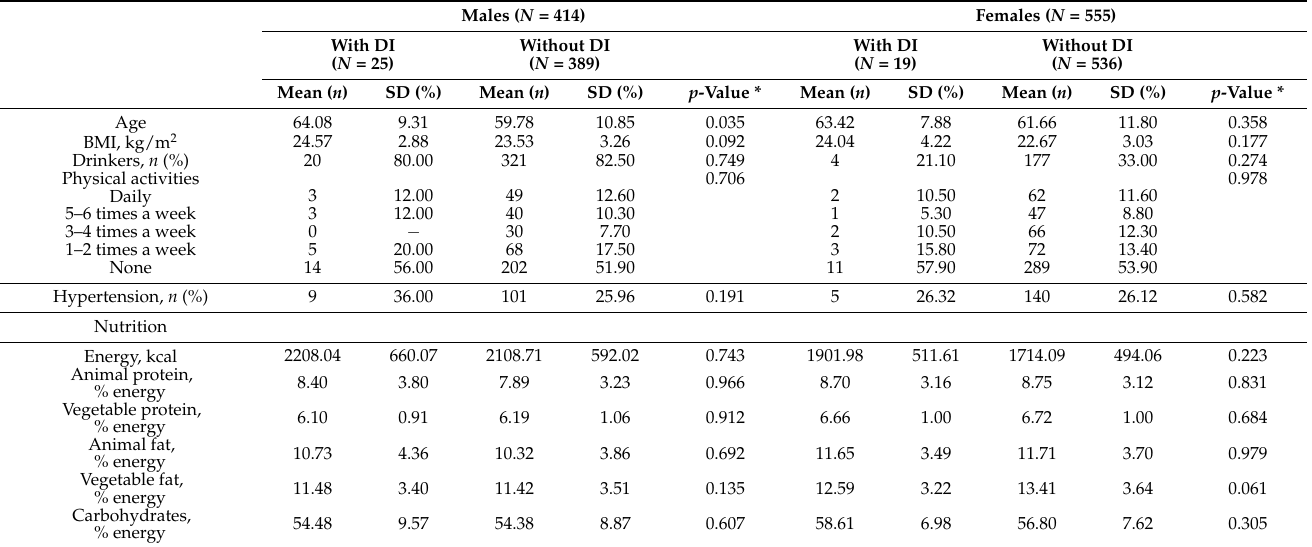
Table 2. Comparison of subjects with and without diabetes